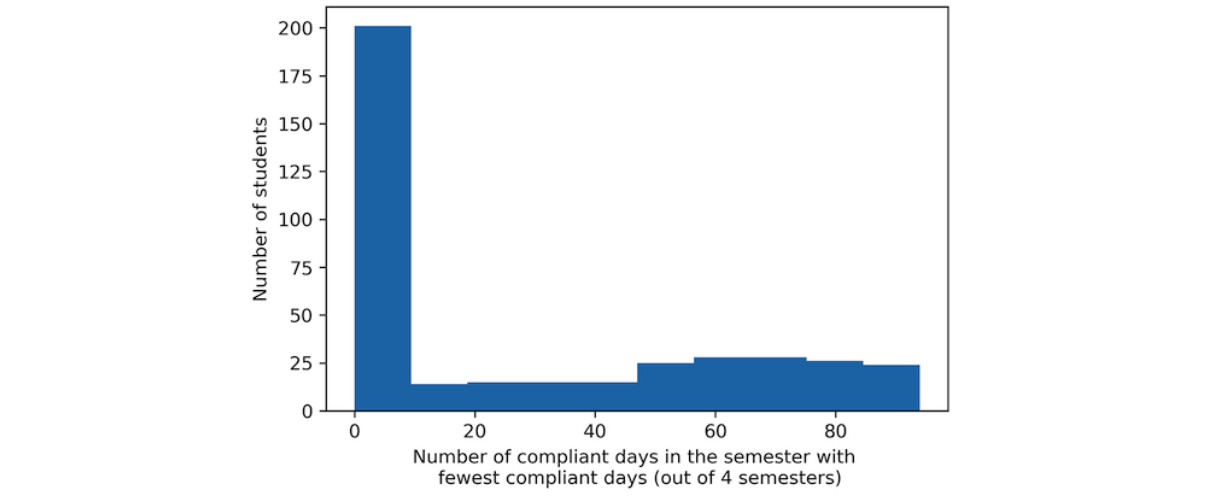
Figure 2. Distribution of participants’number of compliant days in their least compliant semester across the 4 semesters